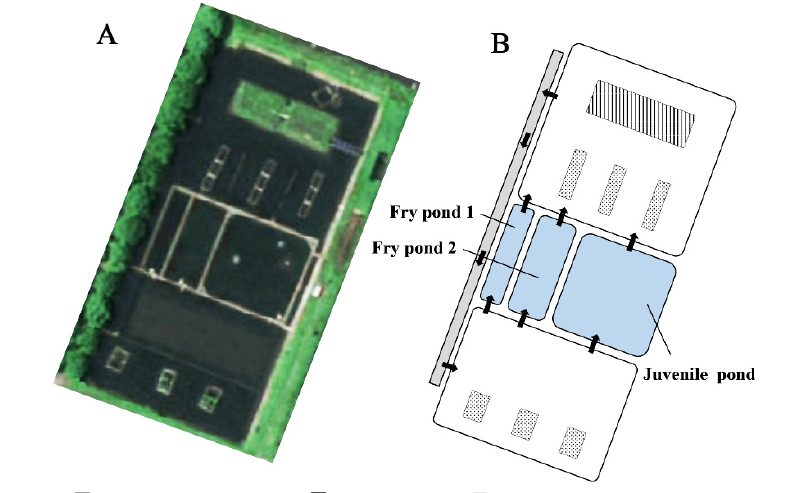
Figure 1. The actual picture ( A ) and structural layout ( B ) of the FMRP.